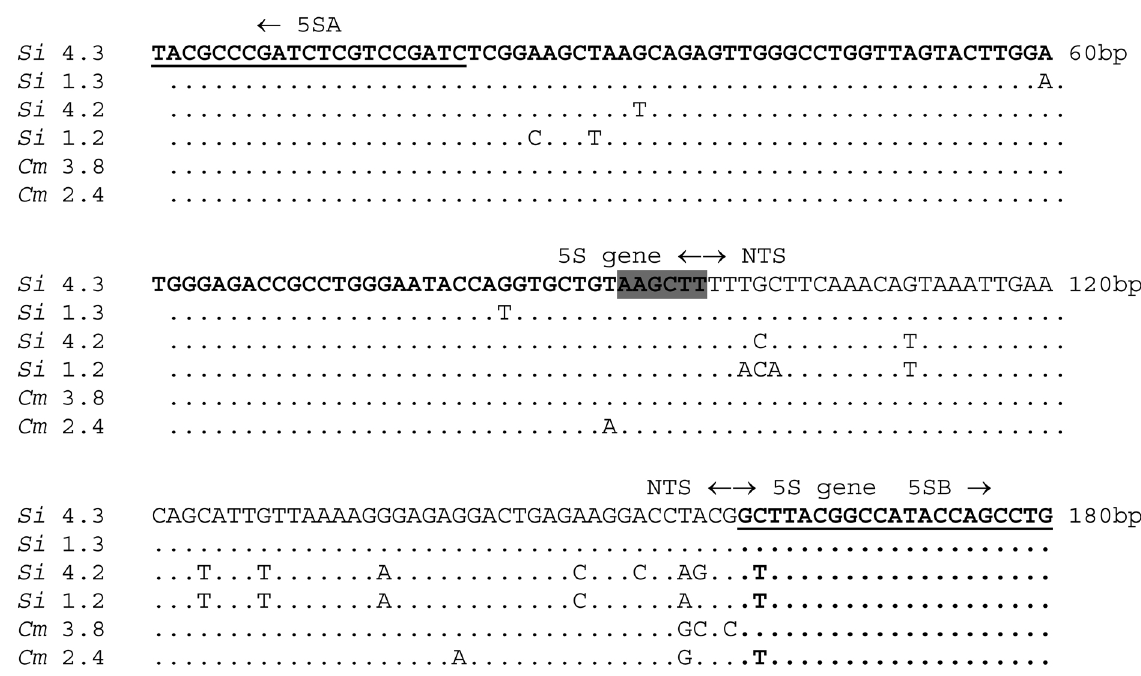
Figure 1 - Alignment of 5S rDNA sequences of Steidachnerina insculpta (Si), and Cyphocharax modesta (Cm). The coding sequence of the 5S rDNA is in bold and the boundaries of the 5S rRNA gene and the NTS are also indicated. Primers 5SA and 5SB used to obtain the sequences are underlined and an arrowhead indicates the amplification direction. The Hind III restriction site (AAGCTT) is shown in gray